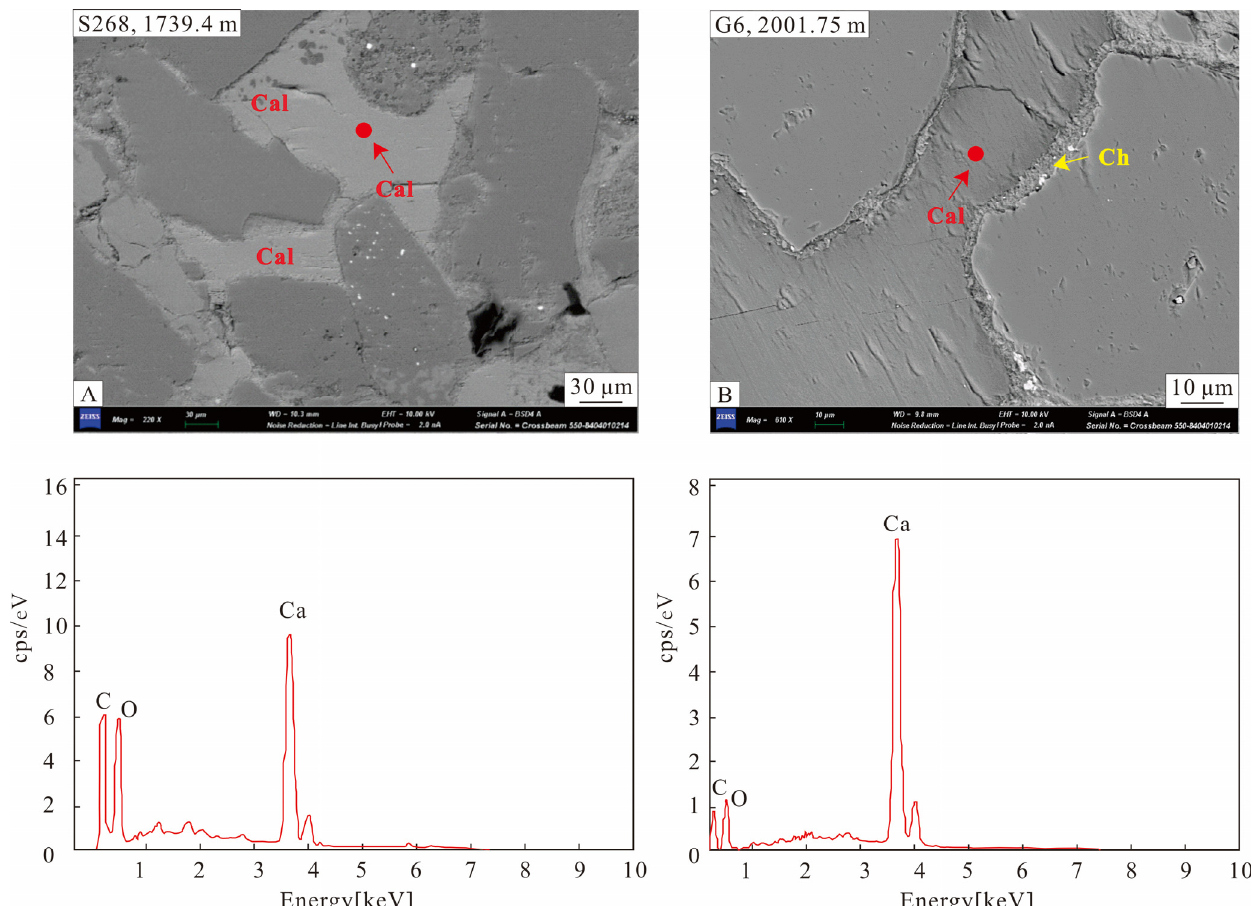
Figure 6. BSE images and corresponding energy spectrums characteristic of two types of calcite. ( A ) BSE image of type-I calcites. ( B ) BSE image of type-II calcites. (Cal = calcite cements; Ch = chlorite; red points represent the locations where the EDS analyses were tested).